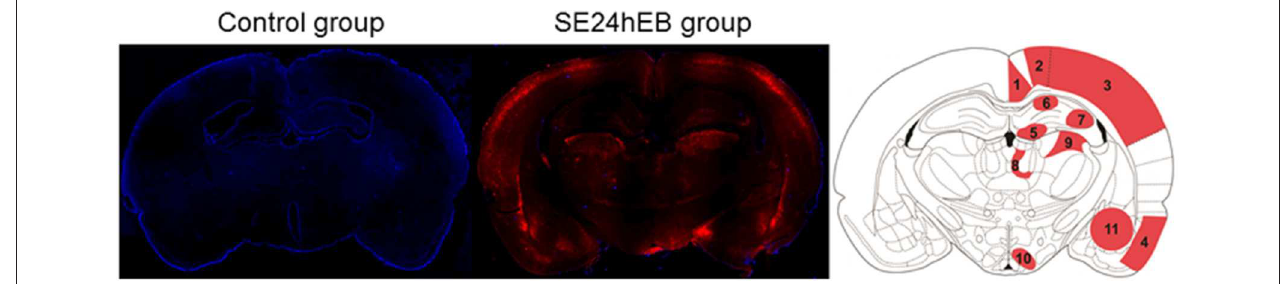
FIGURE 4 | Panoramic view of the brain showing the Evans blue (EB) dye distribution after BBB breakdown. Representative brain slices from Control (left panel) and SE24EB (middle panel) groups obtained by fluorescence microscope. In blue, nuclei of the cells evidenced with DAPI. In red, fluorescence emitted by the EB dye, indicating the sites of BBB breakdown in the SE24hEB group. In the right panel, schematic representation of the main brain areas affected by BBB breakdown in the group SE24hEB: (1) retrosplenial granular cortex (coRSG); (2) motor cortex (coM); (3) somatosensory cortex (coS); (4) piriform cortex (coPir); (5) dentate gyrus (DG); (6) hippocampal CA1 area; (7) hippocampal CA3 area; (8) mediodorsal nucleus of the thalamus; (9) laterodorsal nucleus of the thalamus; (10) ventromedial nucleus of the hypothalamus (VMH); and (11) amygdaloid complex. Bregma − 3.14mm anteroposterior adapted from the rat brain atlas (25). Photomicrographs were taken at a magnification of 100X and panels constructed with Autostitch software (Copyright University of British